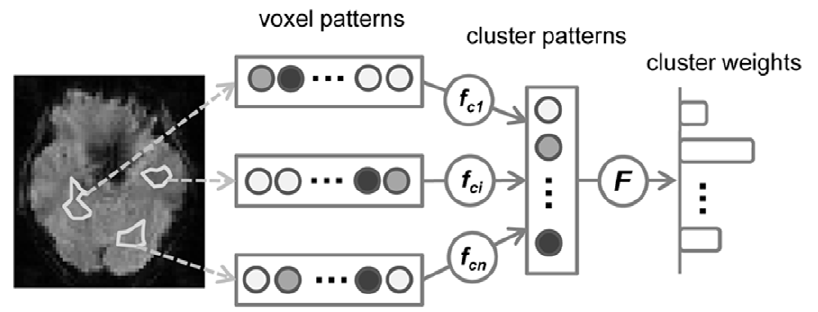
Figure 1. The framework of the mapping informative clusters (MIC) approach. The whole brain was partitioned into homogeneous clusters, where the within-cluster voxel patterns from different clusters were transformed into a cluster pattern consisted of one single value for each cluster. Informative clusters were selected according to their discriminative weights derived from the cluster pattern.